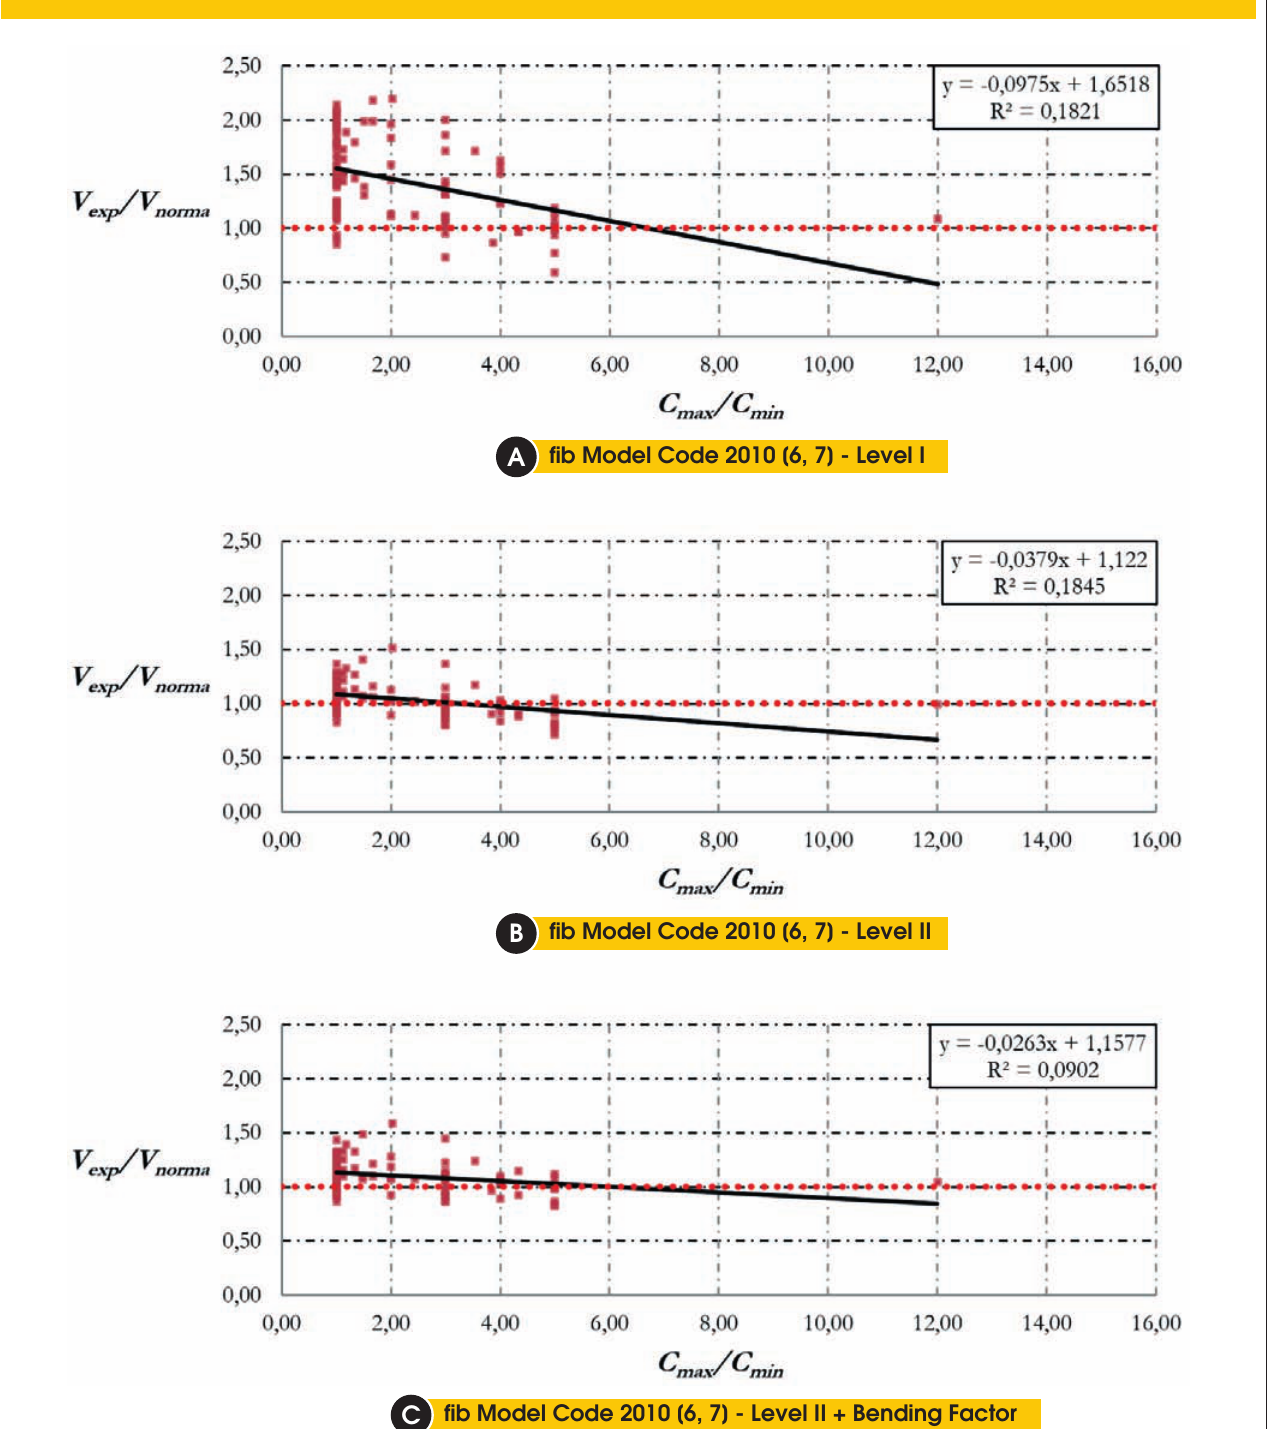
Figure 10 – Tendency of the results according to different